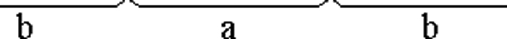
Figure 3 - The sequences extracted from the Regulon DB database have this format: the region “b” on the left and on the right are 10 bases length; region “a” is also 10 bases length, and the RBS sequence is within these